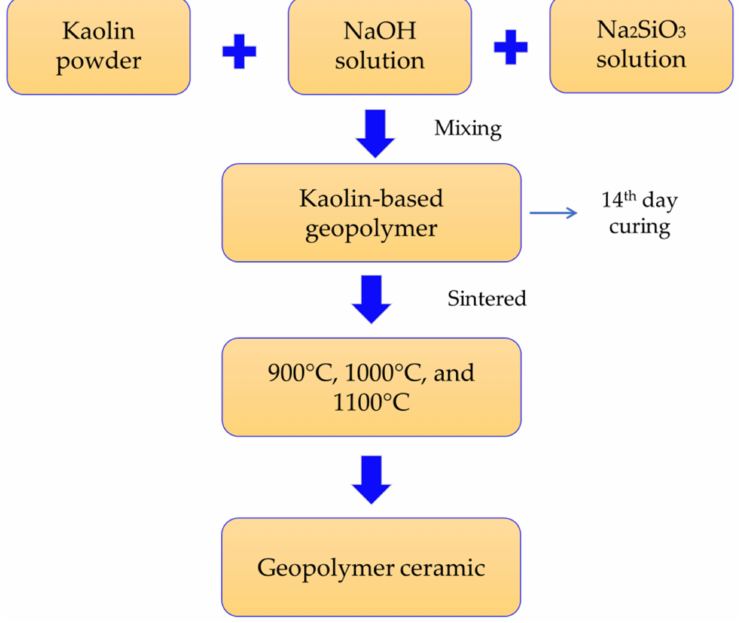
Figure 1. The process of creating kaolin-based geopolymer